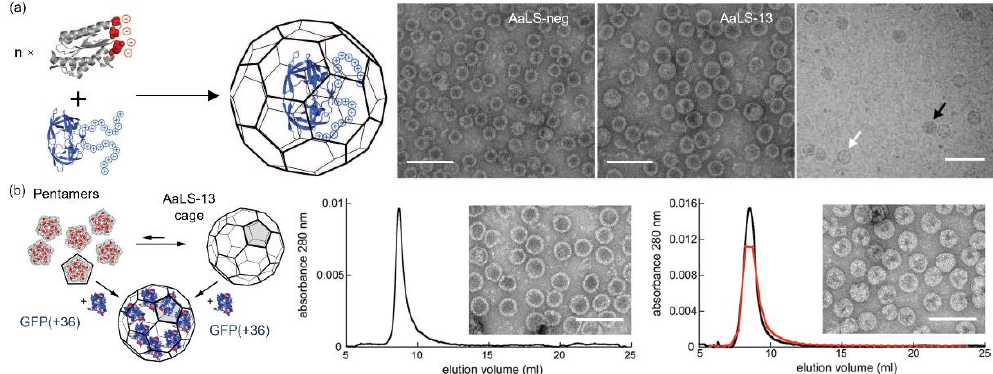
Figure 6. AaLS mutants and the sequestration of cationic cargos. ( a ) Schematic illustration of the loading of a R10-tagged HIV protease into the non-quasi-equivalent AaLS variant, AaLS-13, and the EM images of (left) AaLS-neg, (middle) AaLS-13 and (right) AaLS-13 coproduced with HIV protease-R10 (white and black arrows indicate empty and protease-loaded cages, respectively). Scale bar: 100 nm. From [76]. Reprinted with permission from AAAS. ( b ) Schematic illustration of the two approaches to load AaLS-13 with GFP(+36), and the characterization results (chromatogram and TEM) of (left) empty and (right) loaded AaLS-13. In both chromatogram graphs, black lines indicate protein absorption and red dots indicate the relative fluorescence of individual fractions. Scale bar: 100 nm. Reprinted with permission from [77]. Copyright (2012) American Chemical Society.